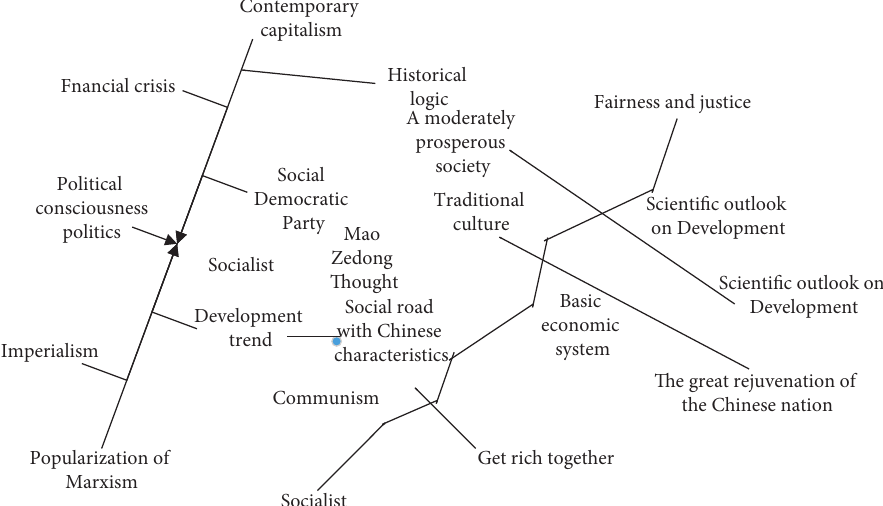
Figure 8: Keyword mapping of Marxist theory journals in 2013.